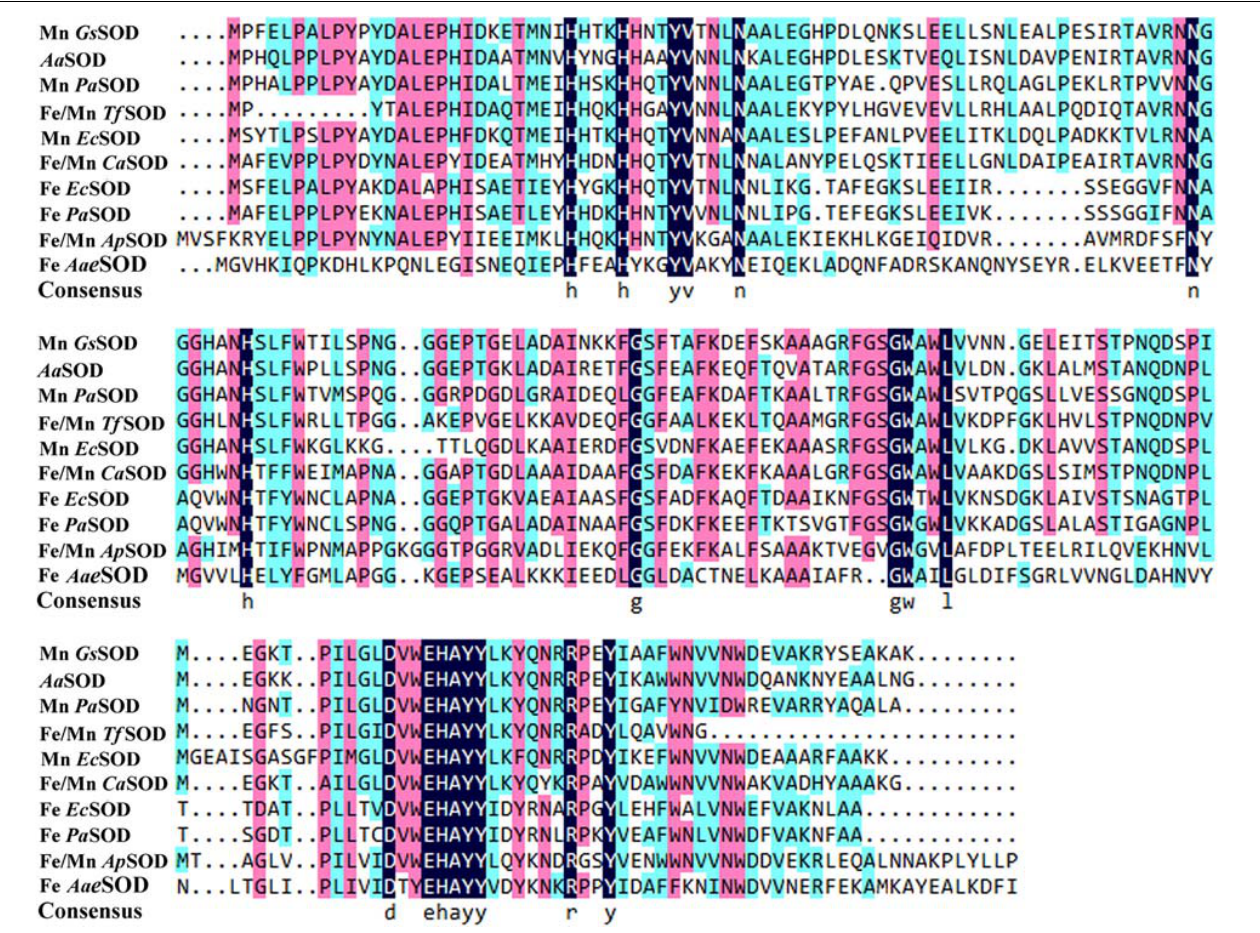
FIGURE 2 | Multiple alignment of Aa SOD with other identified Fe, Mn, or Fe/Mn type SODs that retrieved from NCBI database. Gs SOD: Geobacillus stearothermophilus , Aa SOD: this study, Pa SOD: Pseudomonas aeruginosa , Tf SOD: Thermus filiformis , Ec SOD: Escherichia coli , Ca SOD: Chloroflexus aurantiacus , Ap SOD: Aeropyrum pernix , Aae SOD: Aquifex aeolicus